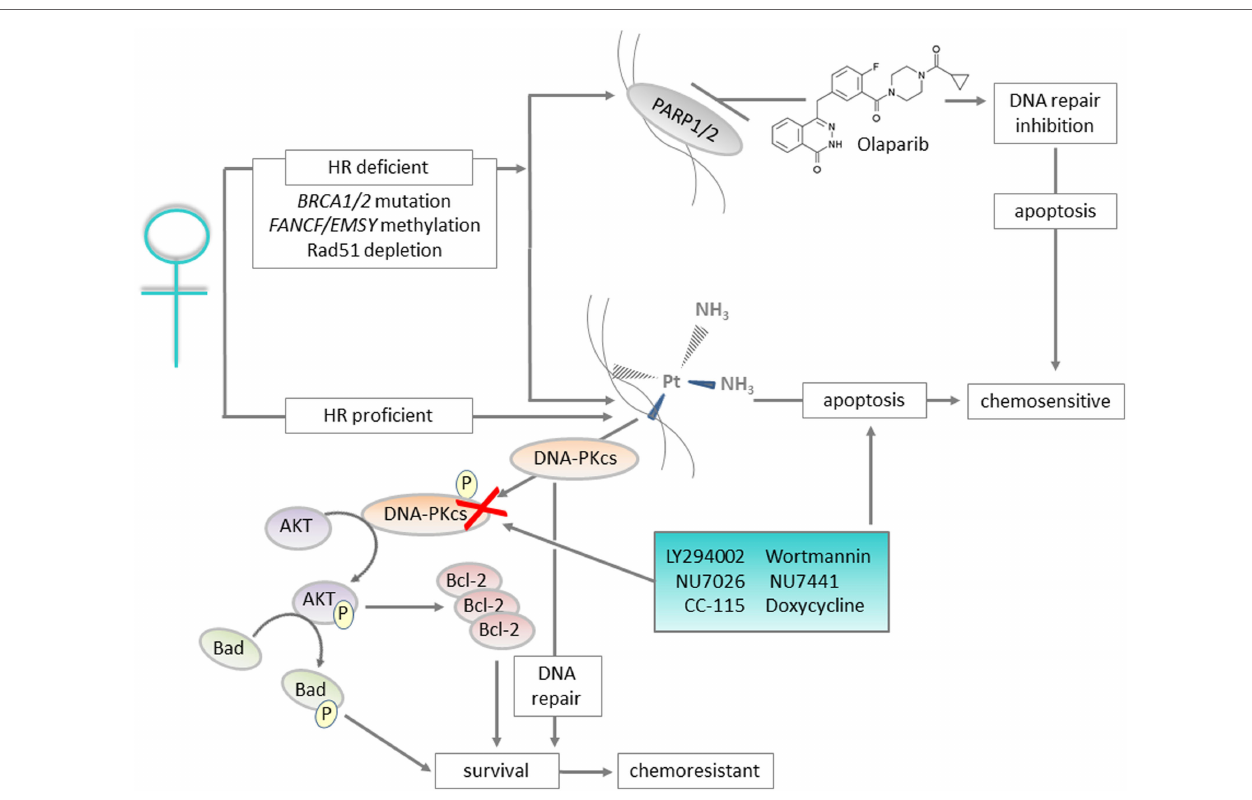
FiGURe 1 | Graphical summary: DNA repair proteins such as DNA-PKcs can be targeted to improve outcomes for patients with ovarian cancer . Ovarian cancers with defects in the homologous recombination (HR) pathway are initially sensitive to platinum treatment, and also respond to Olaparib that targets the base excision repair pathway protein PARP. For the majority of cases, which are HR proficient, platinum-based chemotherapy is still utilized but resistance is likely. For patients with platinum-resistant disease, inhibition of DNA-PKcs, a key component of the non-homologous end joining pathway, represents a targeted approach to prevent the pro-survival AKT and anti-apoptotic signaling associated with